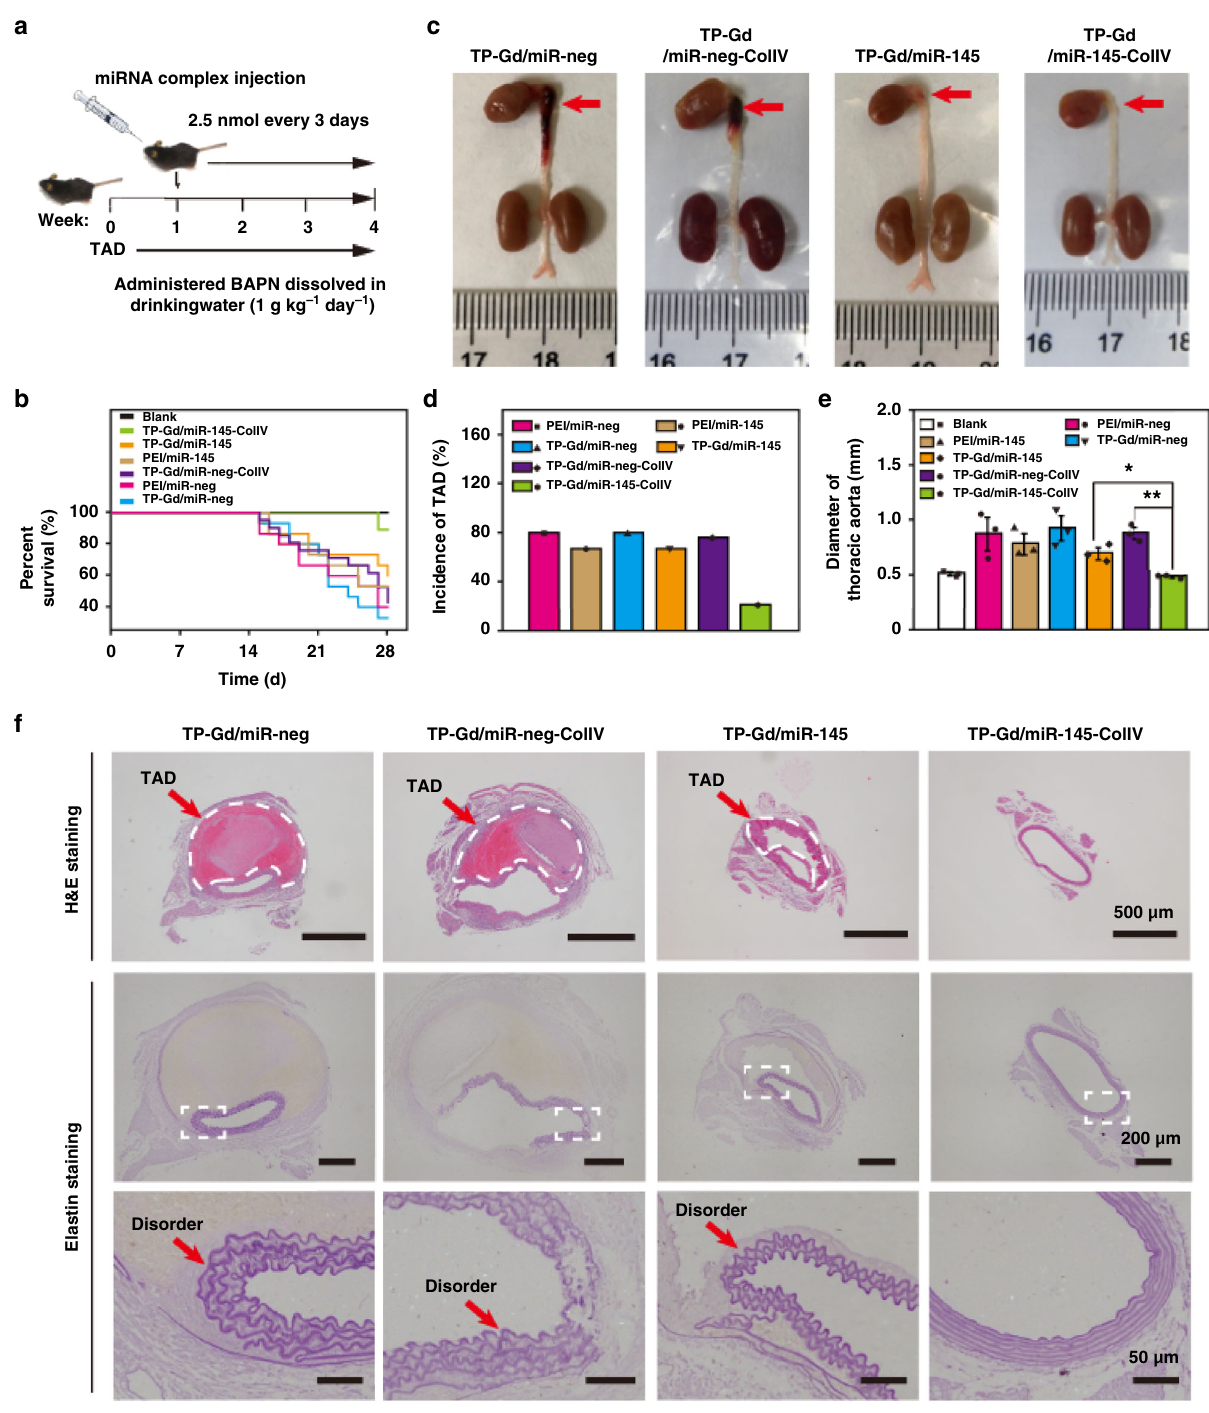
Fig. 5 In vivo effects of saline and polycation/miR-145 complexes on BAPN-induced TAD model. a Time axis of administration, b percent survival, c general phenotypic pattern captured by digital camera, d incidence of TAD and e diameters of thoracic aortic arch of all the groups, and f representative images of H&E- and elastin-thoracic aortic arches from all the treated mice. (* p < 0.05 and ** p < 0.01, see “ Statistical analysis ” in “ Methods ” ; n ≥ 15 animals; error bars represent standard deviation; source data of b – d are provided as a Source Data fi